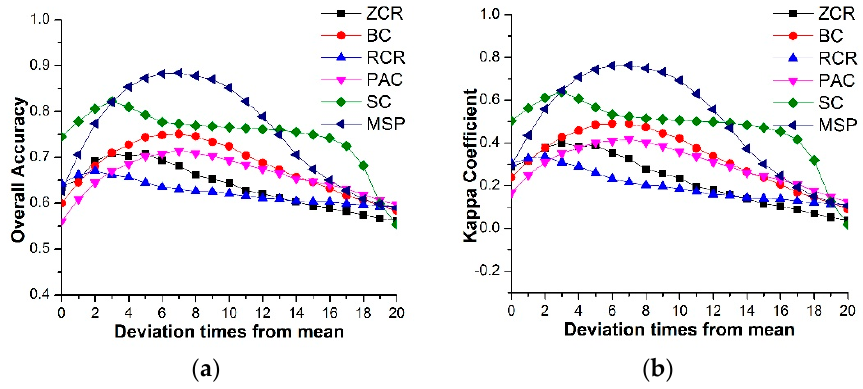
Figure 9. The accuracy assessment curves of the components and integrated methods, where ZCR, BC, RCR, PAC and SC label the contributions from the change magnitudes of the zero-crossing rate, baseline cumulation, relative cumulation rate, phase angle cumulant, and spectral correlation, respectively. ( a ) Overall accuracy; ( b ) kappa coefficient. Both ( a ) and ( b ) are deviation times from the mean of the change magnitude ( x -axis) with units of 0.25 multiplied by the standard deviation.